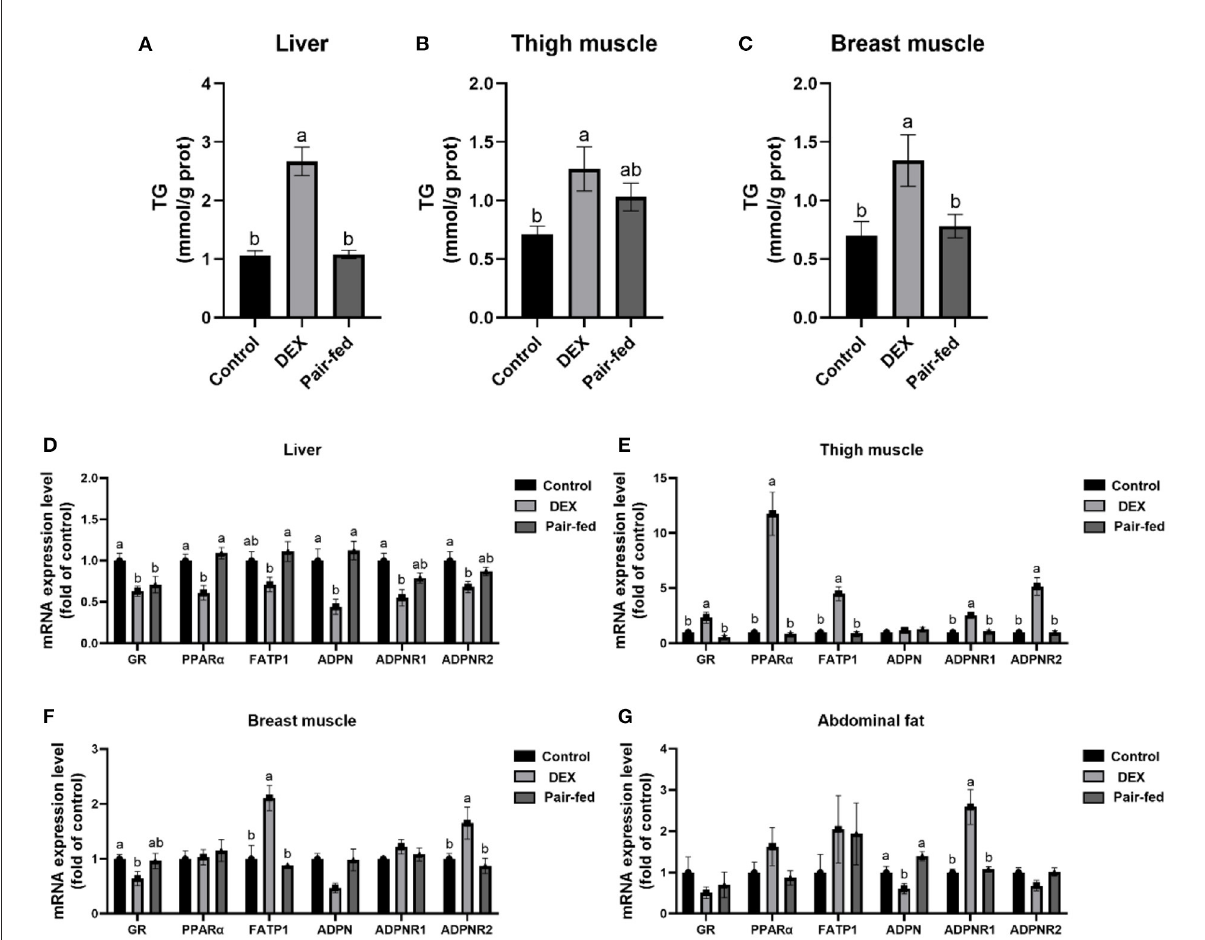
FIGURE2 Effects of dexamethasone on TG content and gene expressions in tissues. TG content in liver (A), thigh muscle (B) , and breast muscle (C) . The mRNA expressions in liver (D), thigh muscle (E) , breast muscle (F) , and abdominal fat (G) . Data are presented as the mean ± SEM ( n = 10). Different superscripts without common letters differ significantly ( P <